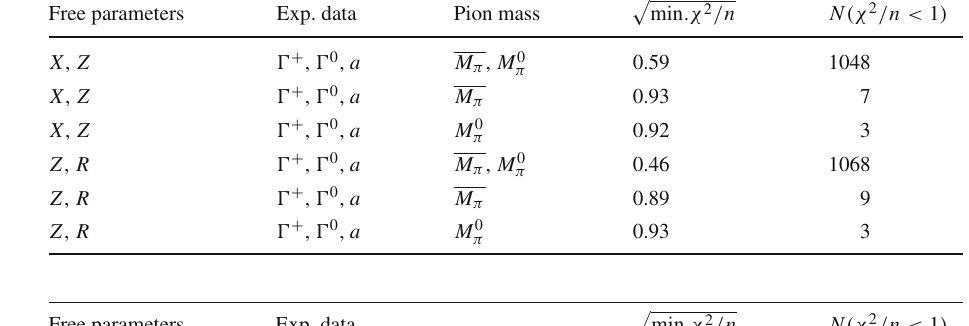
Table 6 χ 2 -based